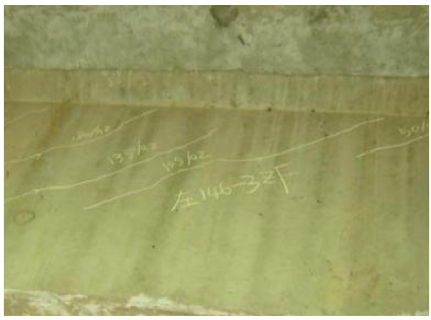
Figure 2: Diagonal cracks on the web.